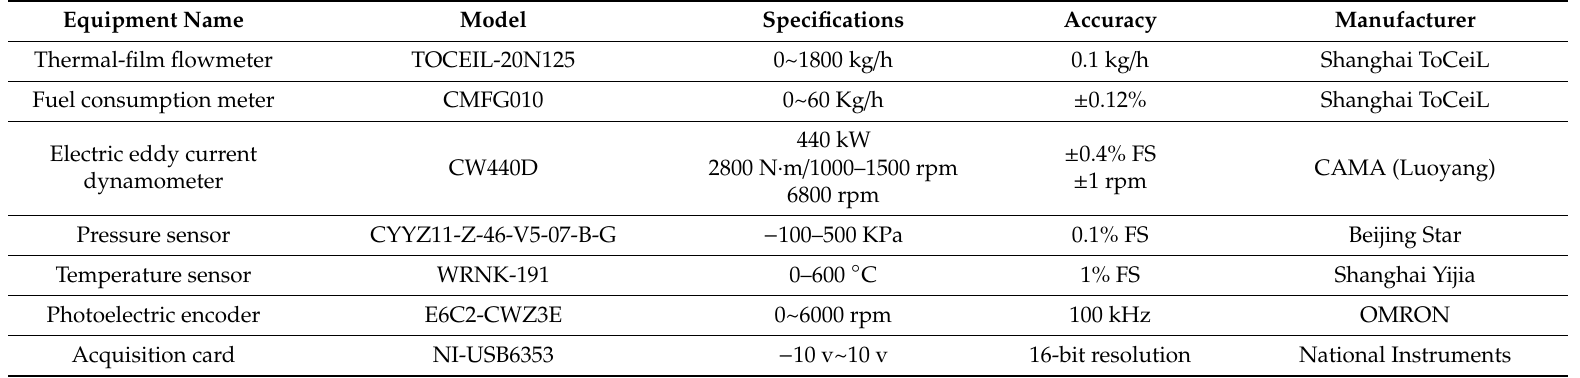
Table 6. Specifications and accuracy of measuring